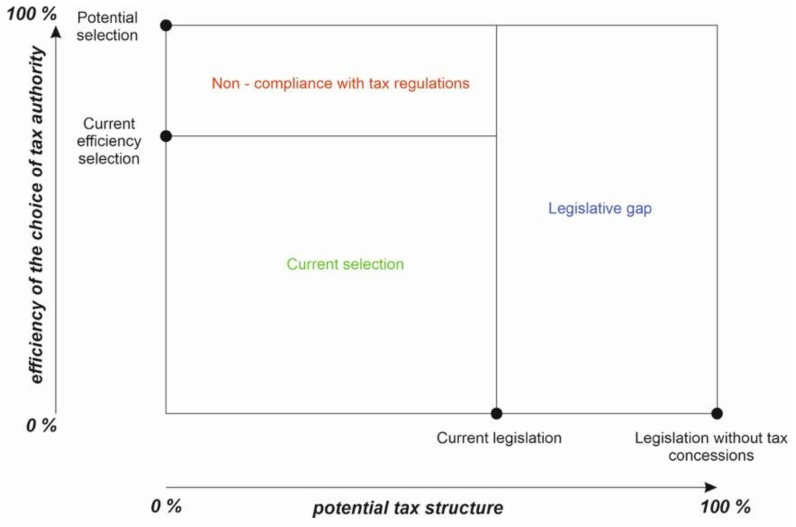
Figure 3. Concept of the tax gap used in the